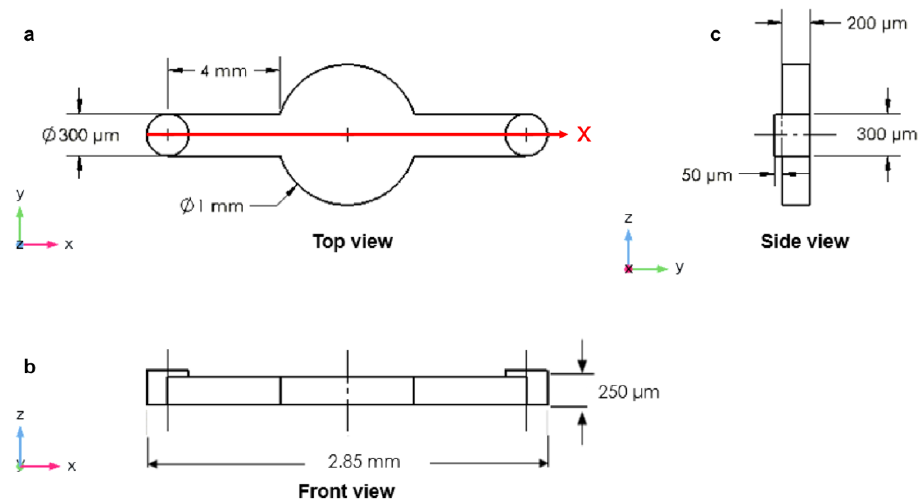
Figure 1. The circular microchamber: ( a ) top view; ( b ) front view; ( c ) side view (D = diameter).